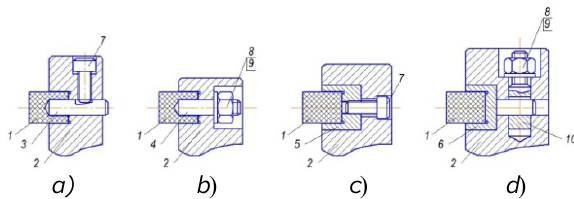
Fig. 1. Fastening structures for replacement grinding segments: a) fastening with a radial bolt; b) fastening with an axial nut; c) fastening with an axial bolt; d) fastening with a radial